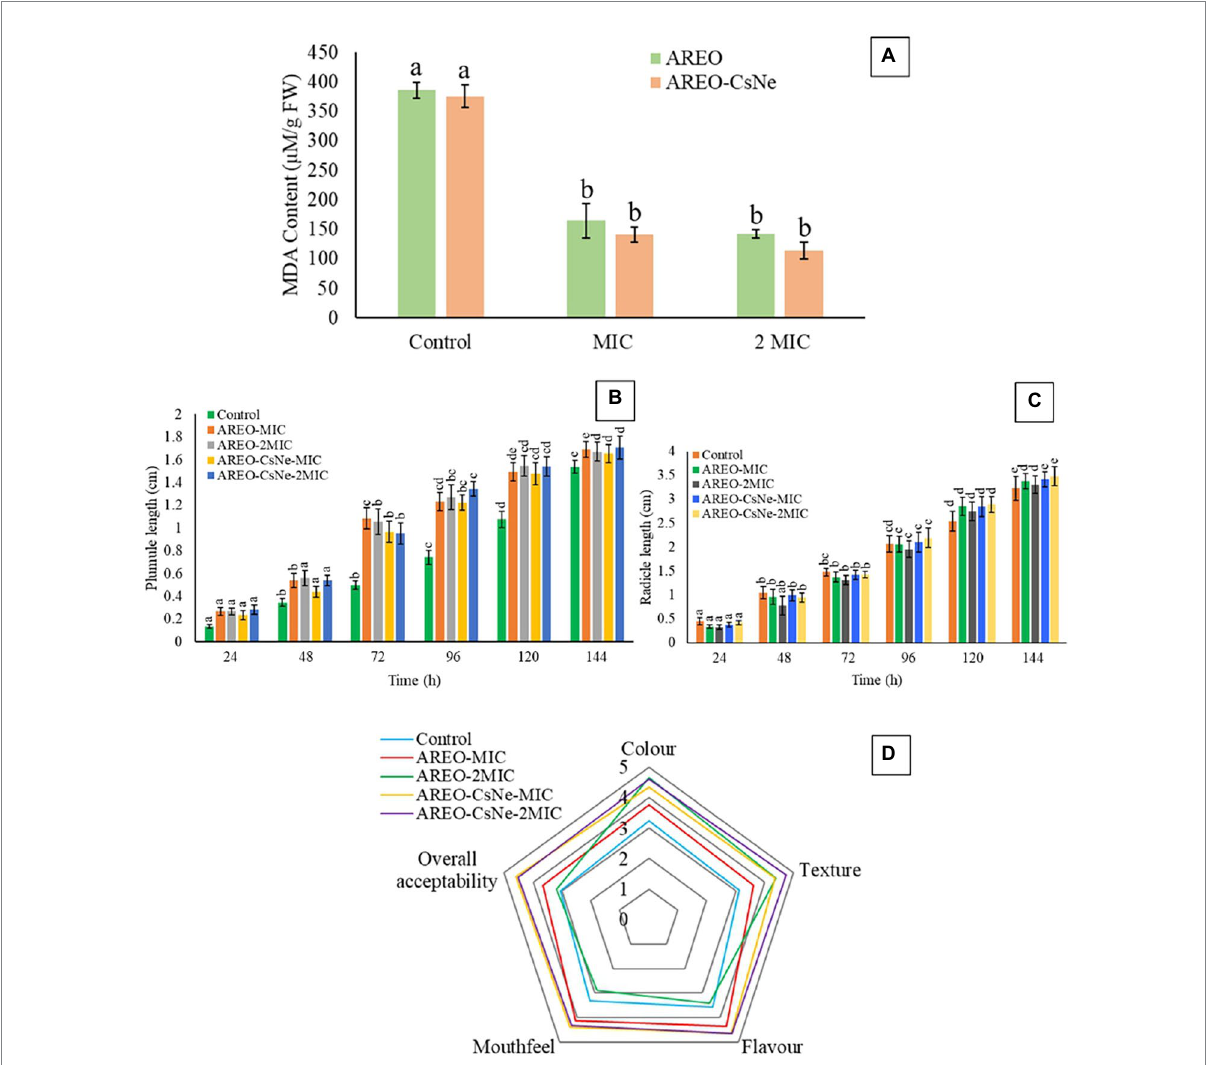
FIGURE 5 Effect of AREO and AREO-CsNe on of lipid peroxidation (A) , phytotoxicity assay (B) 907, (C) , and sensory evaluation (D) of S. italica seed samples treated with AREO and AREO-CsNe at MIC and 2MIC